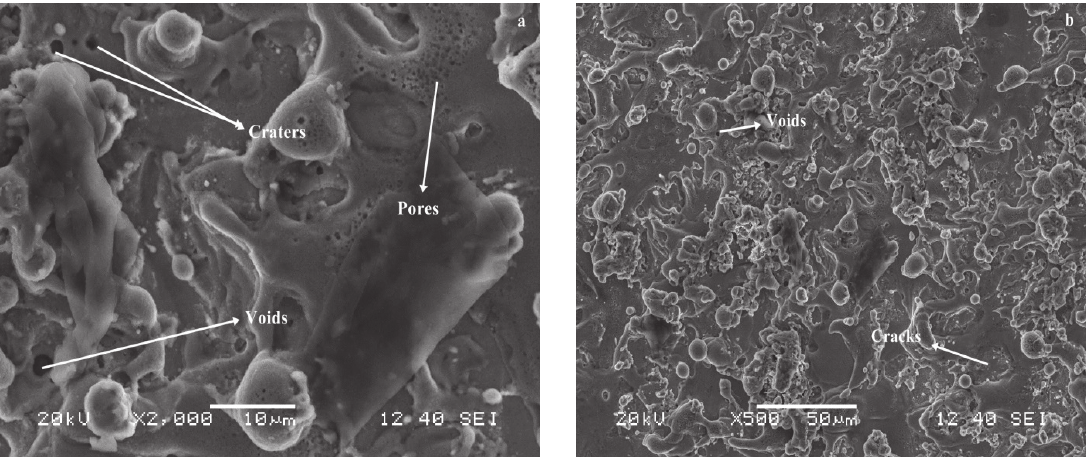
Fig. 5. Micrographs of the material (T ON 119, T OFF 57, W T 4) after machining (a) at 2000X (b) at